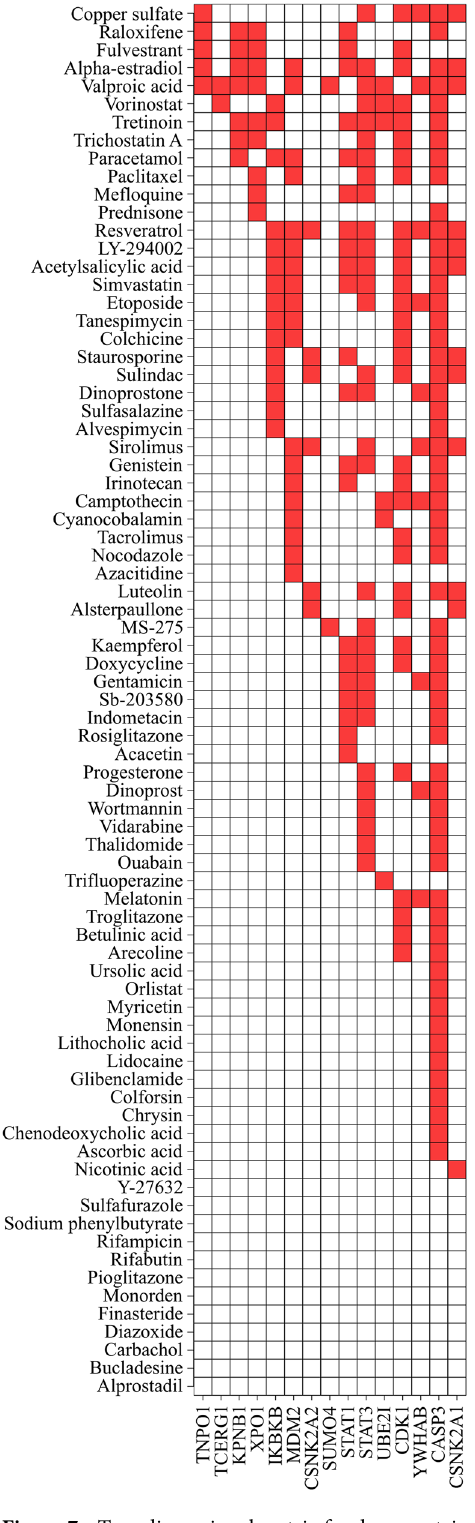
Figure 7. Two-dimensional matrix for drug-protein interactions between 77 filtered drug candidates and 15 shared proteins. Rows and columns represent 77 filtered drug candidates and 15 shared proteins, respectively. The proteins in the figure are arranged from the left in ascending order of the degree in the HPRD. Red squares indicate interactions between proteins and drug candidates found by